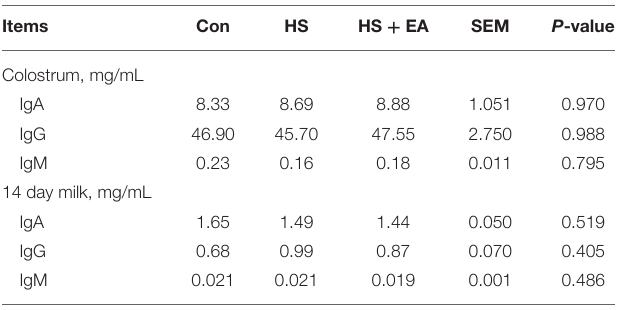
TABLE 8 | Effects of dietary supplementation with EA on immunoglobulin levels in the colostrum and 14 day milk of sows.